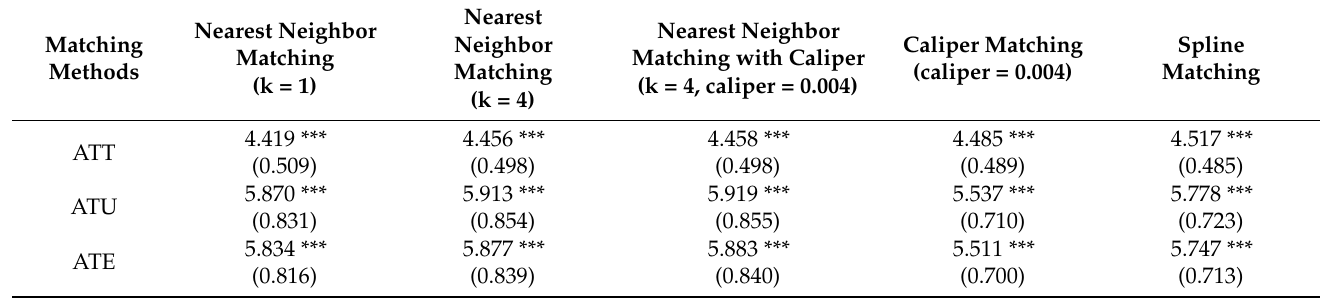
Table 3. Treatment effects of left-behind experience in the whole sample.